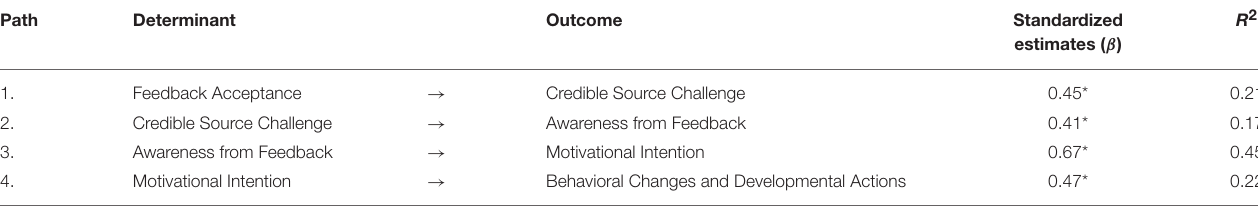
TABLE 4 | Direct paths between latent factors specified in the measurement model.